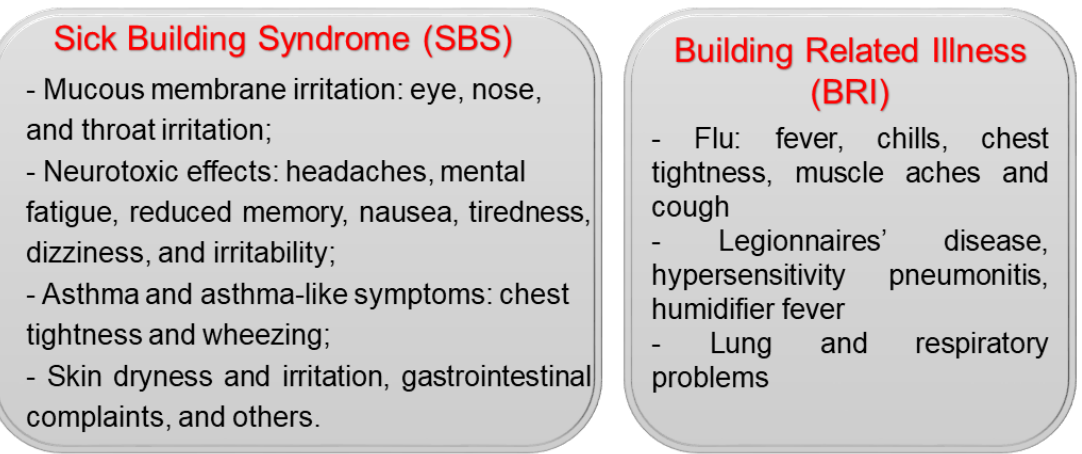
Figure 2. The common symptoms of sick building syndrome (SBS) and building related illness (BRI).